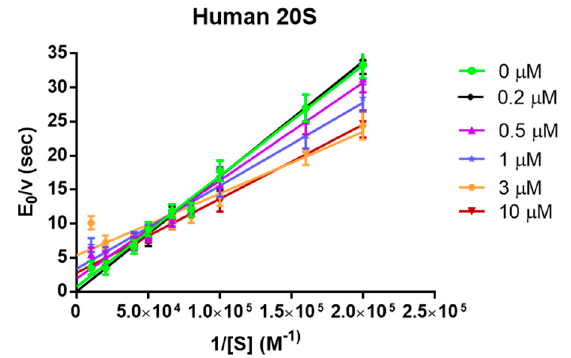
Figure 3. Lineweaver-Burk double reciprocal plot as a function of substrate concentration of 20S proteasome chymotryptic-like activity at di ff erent Tris-T4 concentrations, ranging from 0 to 10 µ M. For the sake of clarity, not all Tris-T4 concentrations have been reported. Continuous lines are the non-linear least-squares fitting of data according to Equation (4).